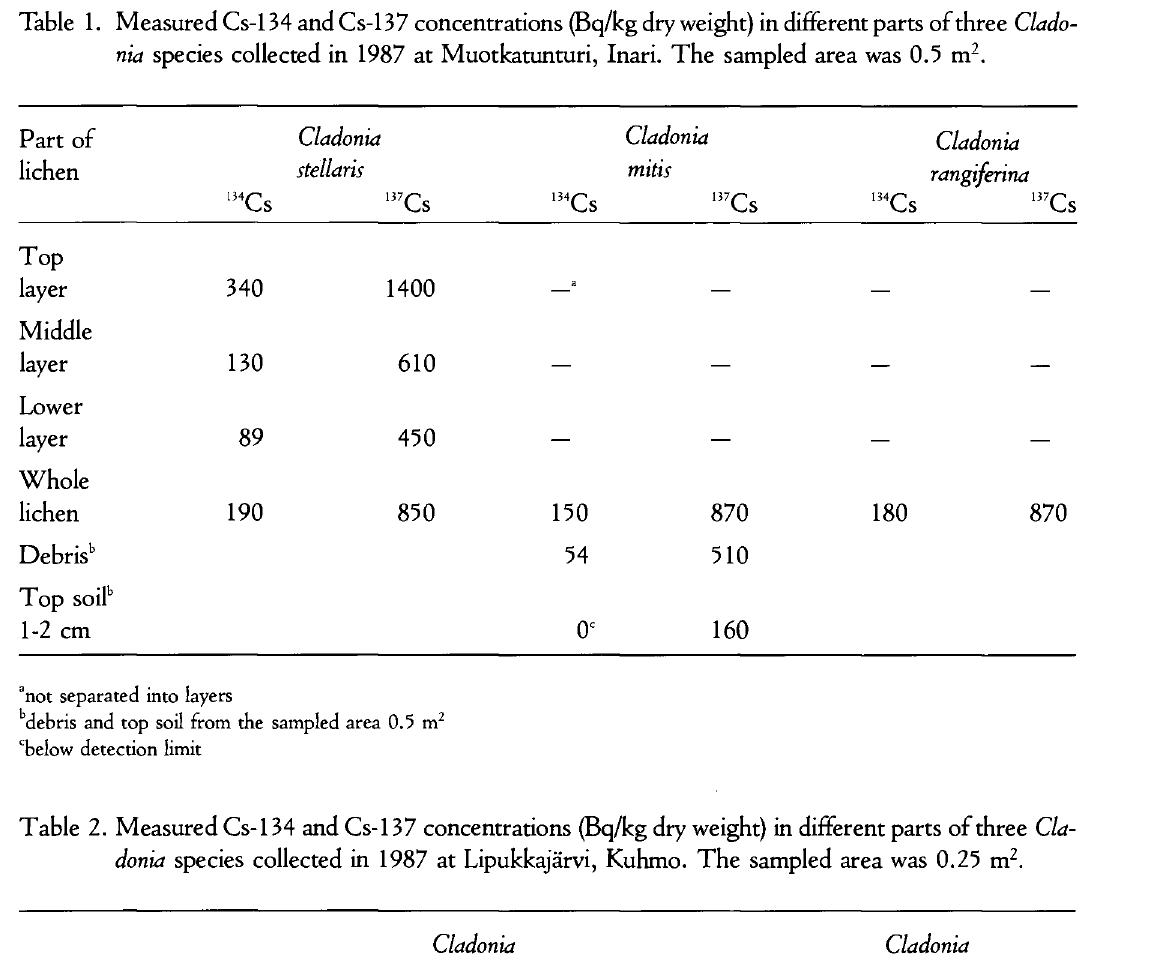
Table 1. Measured Cs-134 and Cs-137 concentrations (Bq/kg dry weight) in different parts of three Clado nia species collected in 1987 at Muotkatunturi, Inari. The sampled area was 0.5 m 2 .